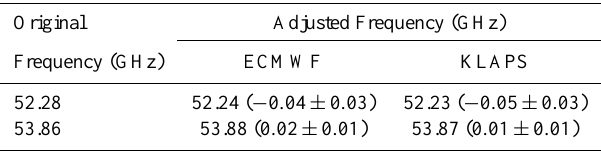
Table 4. The adjusted frequency for the two lower frequencies de- rived from both the ECMWF and KLAPS profiles. The adjusted fre- quency is obtained by taking averages of the frequencies that give the best match between the measured T b ( T M ( T E or T K ). The numbers within the parentheses is averaged differ- b b ence and its standard